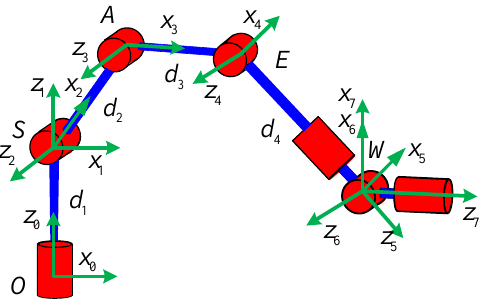
Figure 1. Structure of the redundant manipulator.